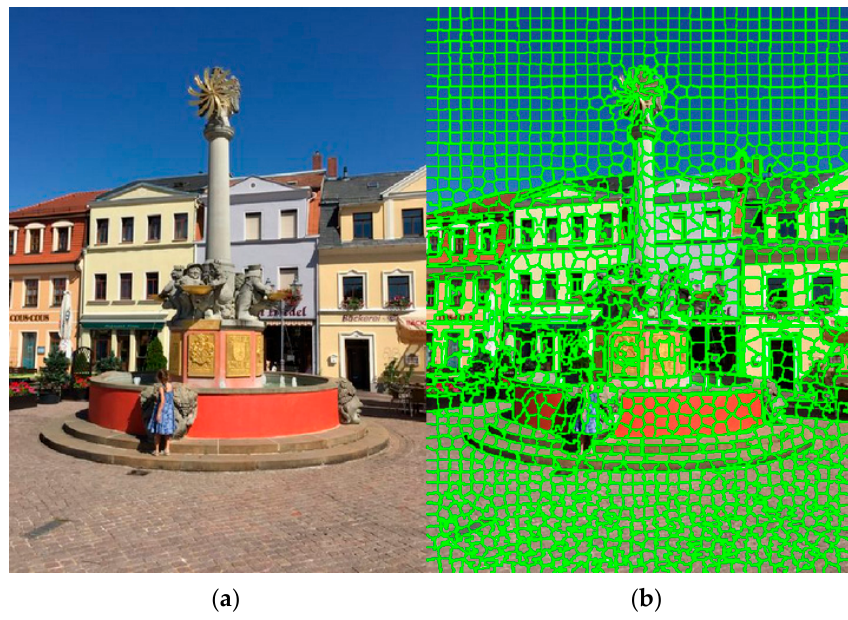
Figure 1. An example of superpixel segmentation: ( a ) The origin image; ( b ) Overlay display of the origin image and the corresponding superpixel segmentation result.